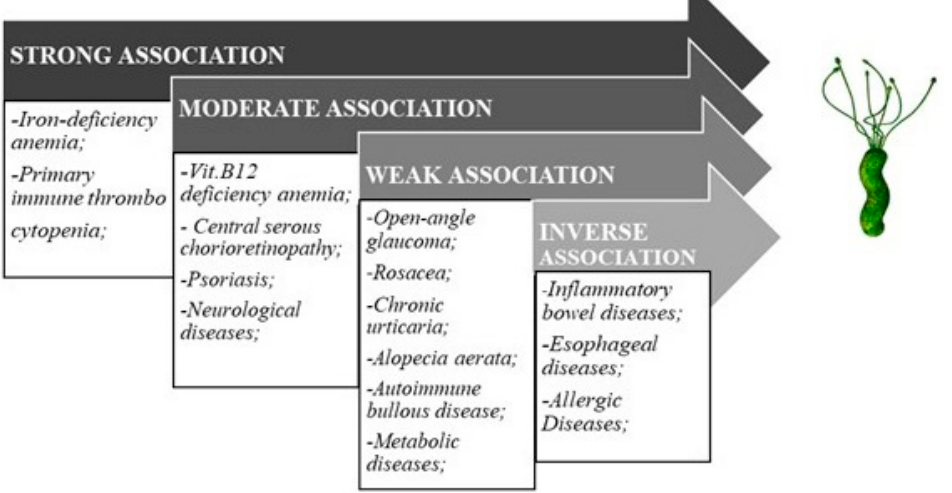
Figure 1. Helicobacter pylori and extra-gastric diseases association.